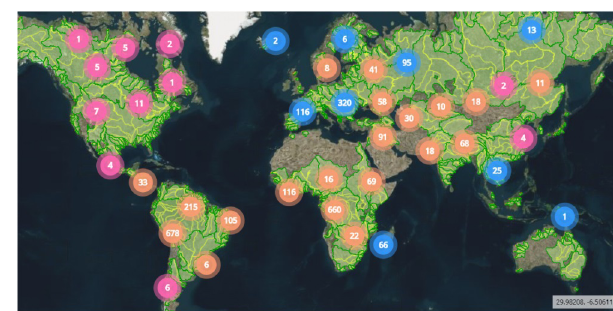
Figure 1. Stations virtuelles disponibles sur Hydroweb pour le suivi des lacs et